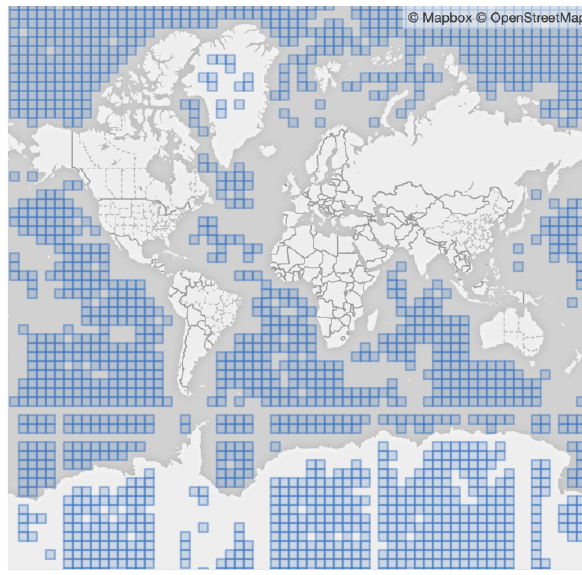
Figure 2. No-feature-modules